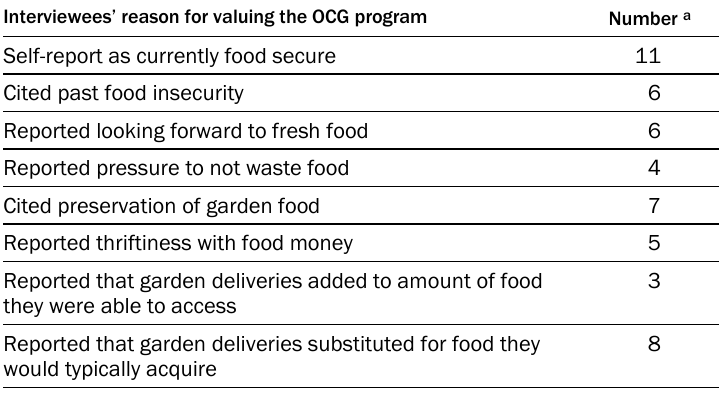
Table 1. Senior Participants Perceptions of Food Insecurity and